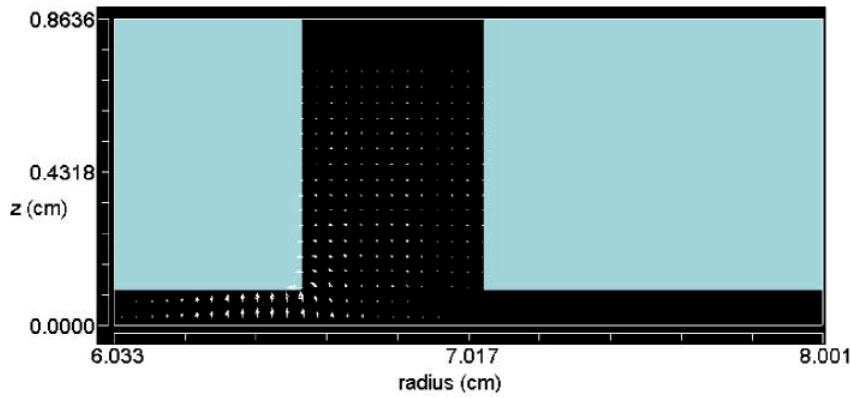
FIG. 19. (Color) MAFIA graphic showing electric field arrows for the WC475 choke resonance with azimuthal index 1. Note the axis orientation. The bottom edge of the plot is the symmetry plane at the gap